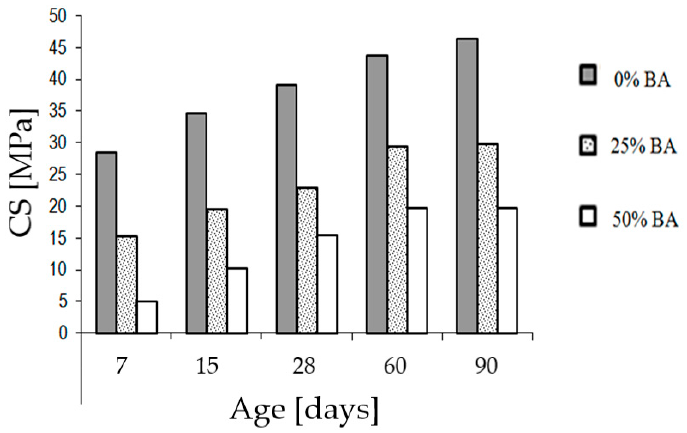
Figure 5. Compressive strength of mortar containing bottom ash.